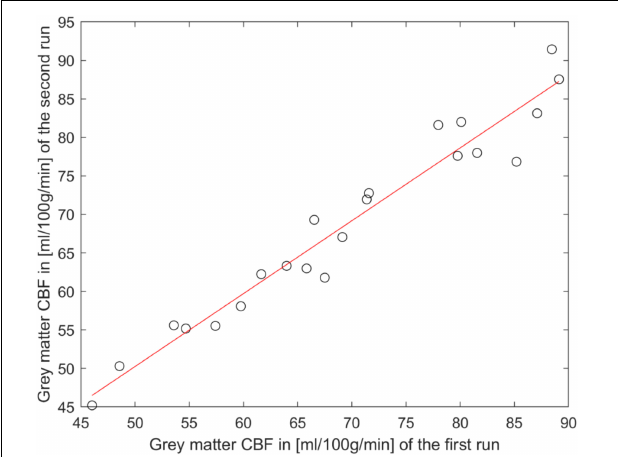
FIGURE 5 | Substantial reproducibility of pCASL acquisitions: The mean CBF of both runs for the gray matter region-of-interest from Skyra acquisitions is compared to those from mMR Biograph acquisitions. A circle represents one participant. The straight red line is the linear fit of these